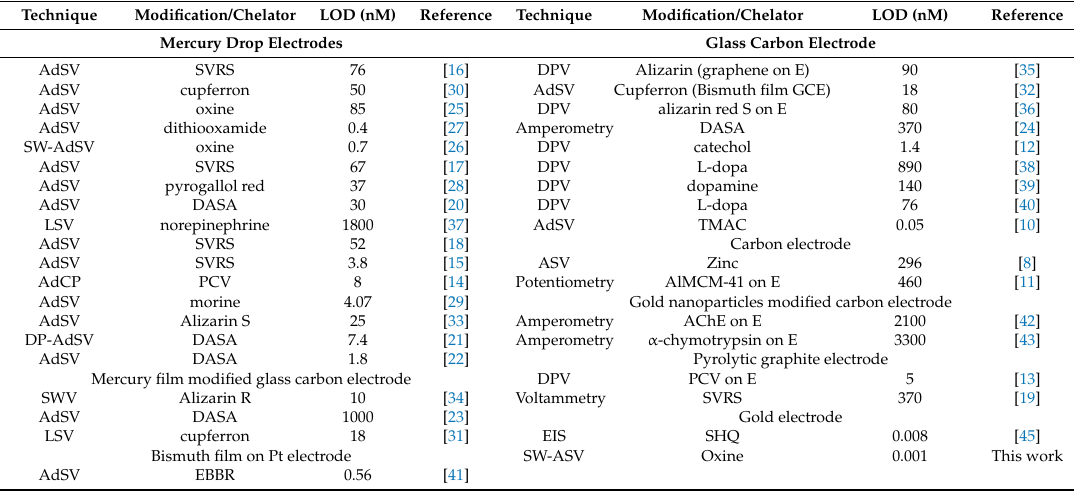
Figure 6. LPME-SW-ASV of Al(III) with different concentrations (from 0.1 to 1.2 ng L − 1 ). Inset: Corresponding calibration plots. LPME conditions are same as Figure 3. The parameters of SW-ASV are same as Figure 4. Table 1. Comparison of the proposed method with other electrochemical techniques for the determination of Al(III).